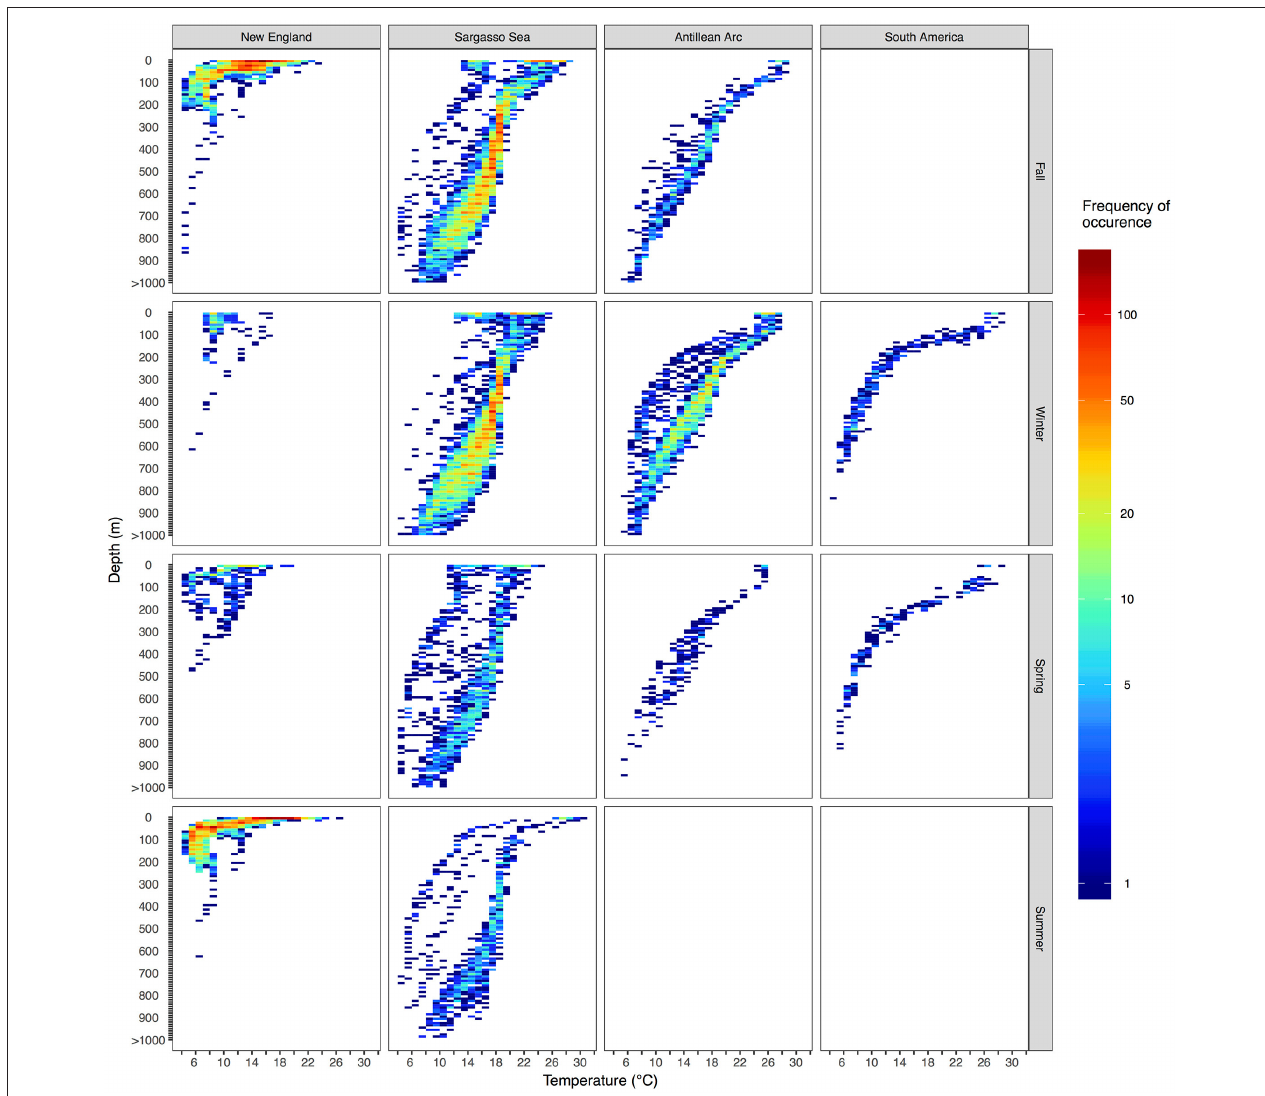
FIGURE 7 | Vertical habitat envelopes of basking sharks. Temperature and depth data are binned every 1 ◦ and 25m, respectively. Depths deeper than 1,000m are added to the last bin. The bounds for each region are shown as boxes in Figure 1 . Note the color bar is on a log scale. Summary statistics for each region and season are shown in Table 2 , and blank panels indicate no data were collected for that region-season